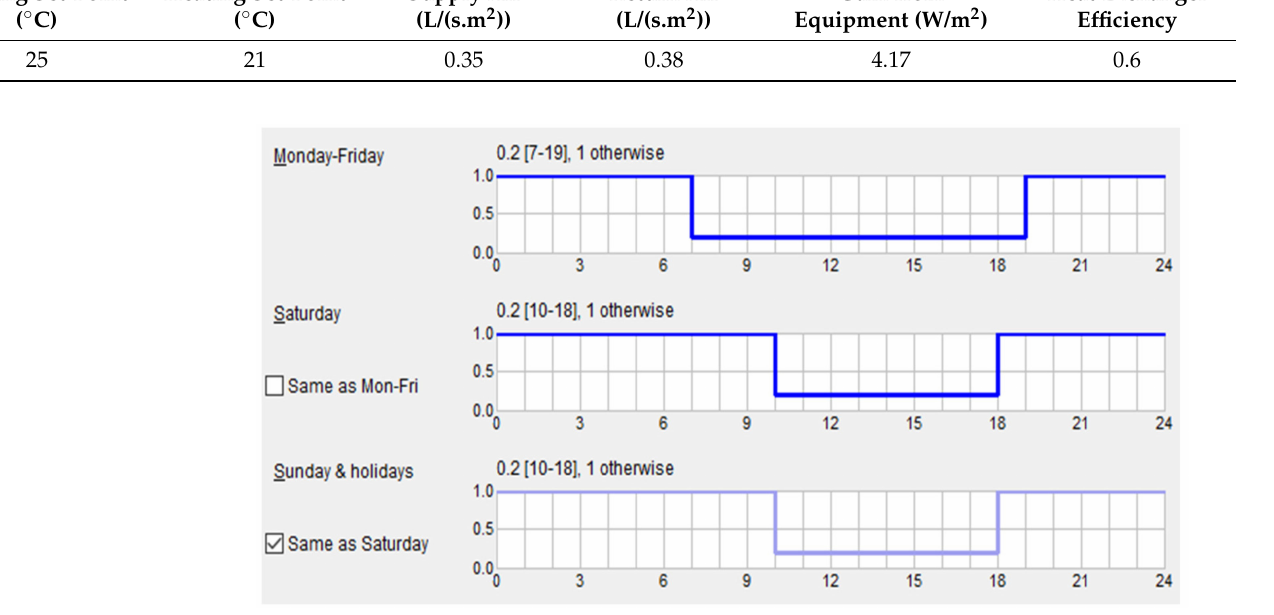
Figure 4. Occupancy schedule set for the building defined in in IDA-Indoor and Climate Energy (IDA-ICE)